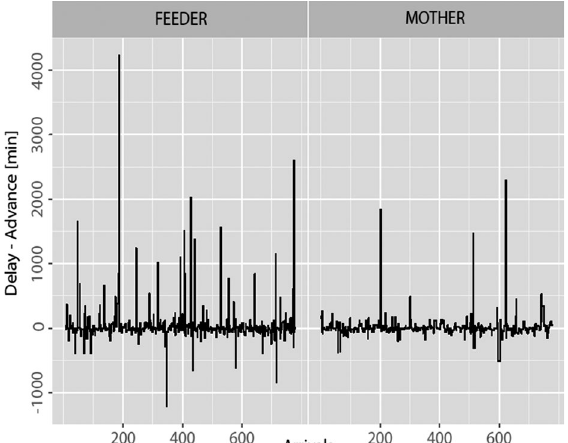
Fig. 4. A two-dimensional feature space partitioned by recursive binary